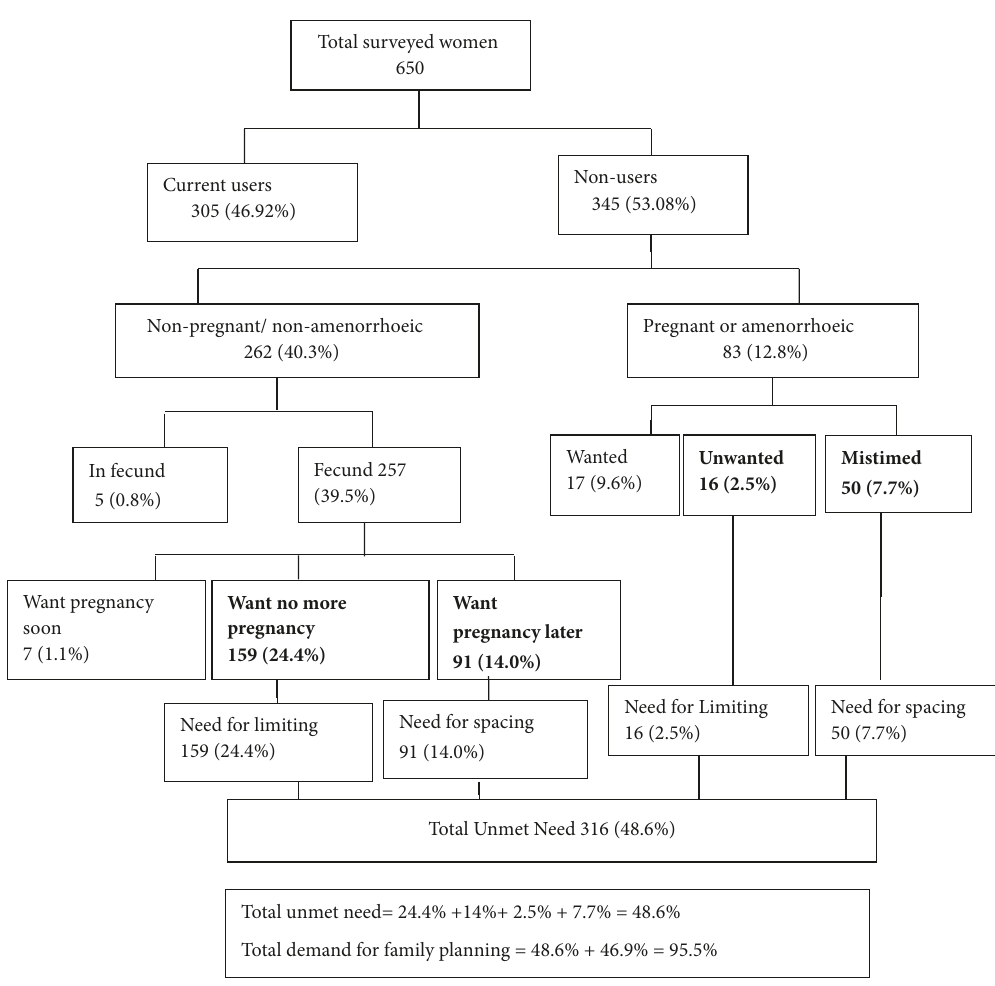
Figure 1: Unmet need for contraception (Westoff model) . Note. Fifteen respondents who are not using any contraceptive methods with the reasons of absence of husbands from last one year are excluded from the total unmet